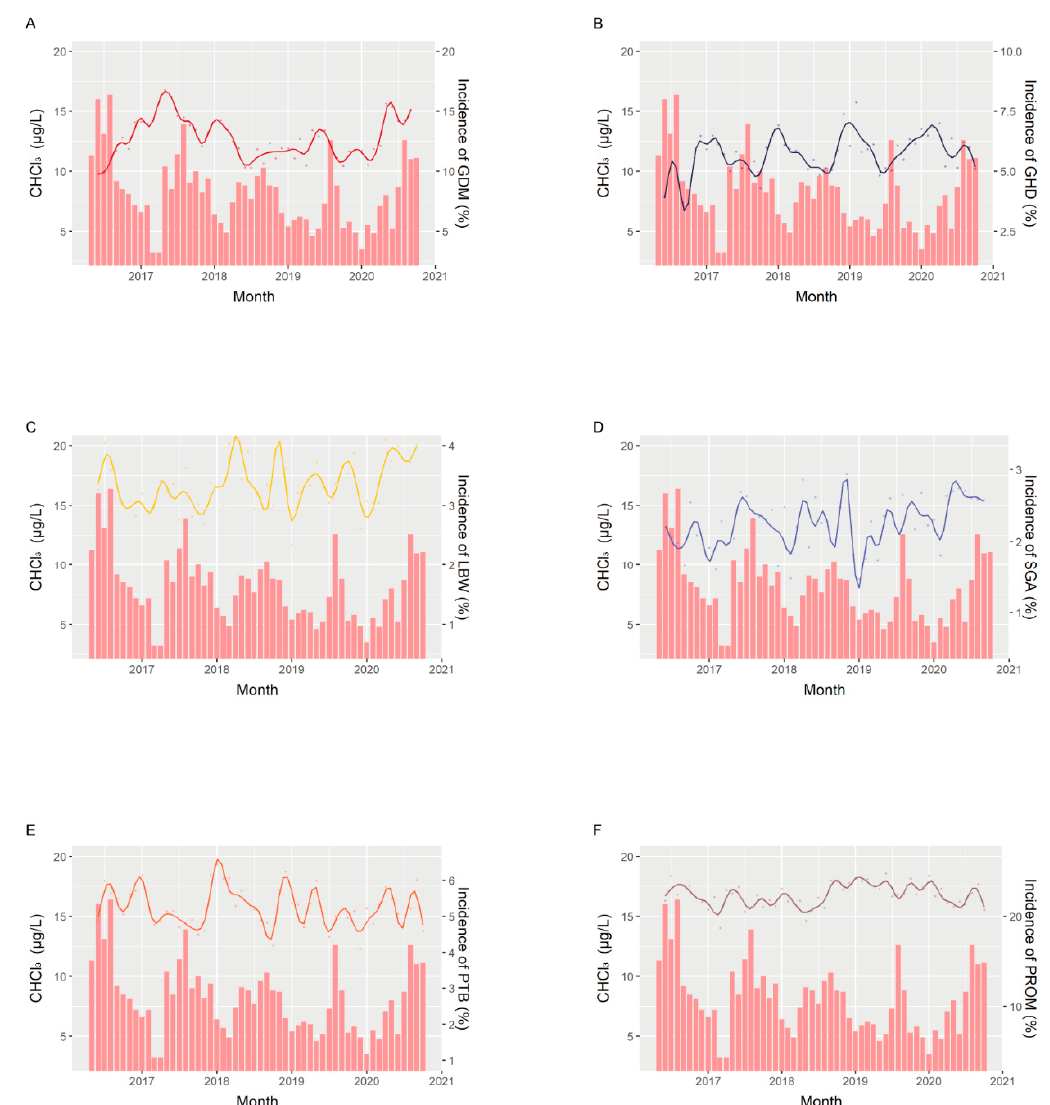
Figure 2. Trends of chloroform levels and monthly attack rates of perinatal outcomes. Histogram shows the trends of chloroform levels, and fitted spline curve shows the monthly attack rates of ( A ) gestational diabetes mellitus (GDM) and ( B ) gestational hypertension disorders (GHD), ( C ) low birth weight (LBW), ( D ) small for gestational age (SGA), ( E ) preterm birth (PTB) and ( F ) prelabor rupture of membranes (PROM).